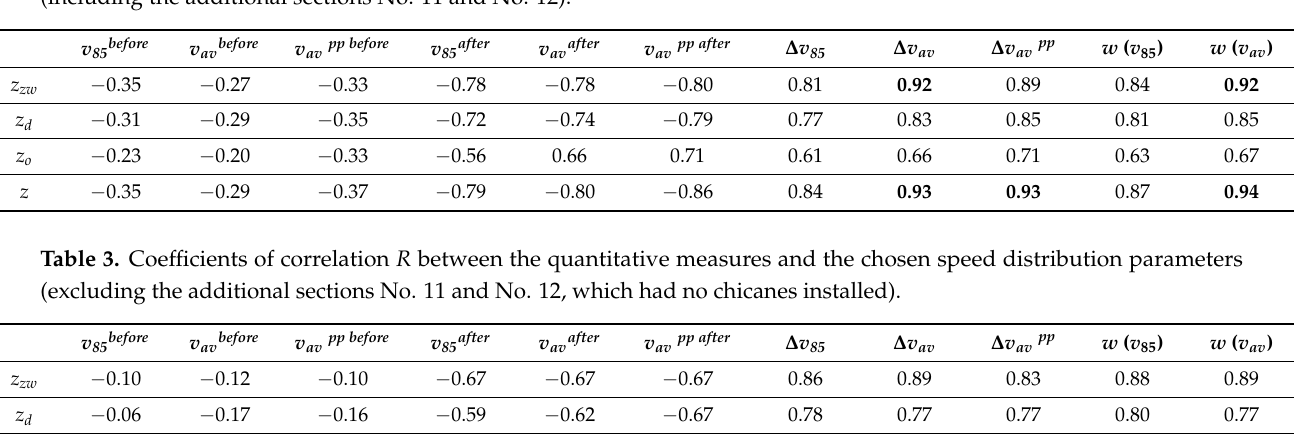
Table 2. Coefficients of correlation R between the quantitative measures and the chosen speed distribution parameters (including the additional sections No. 11 and No. 12).